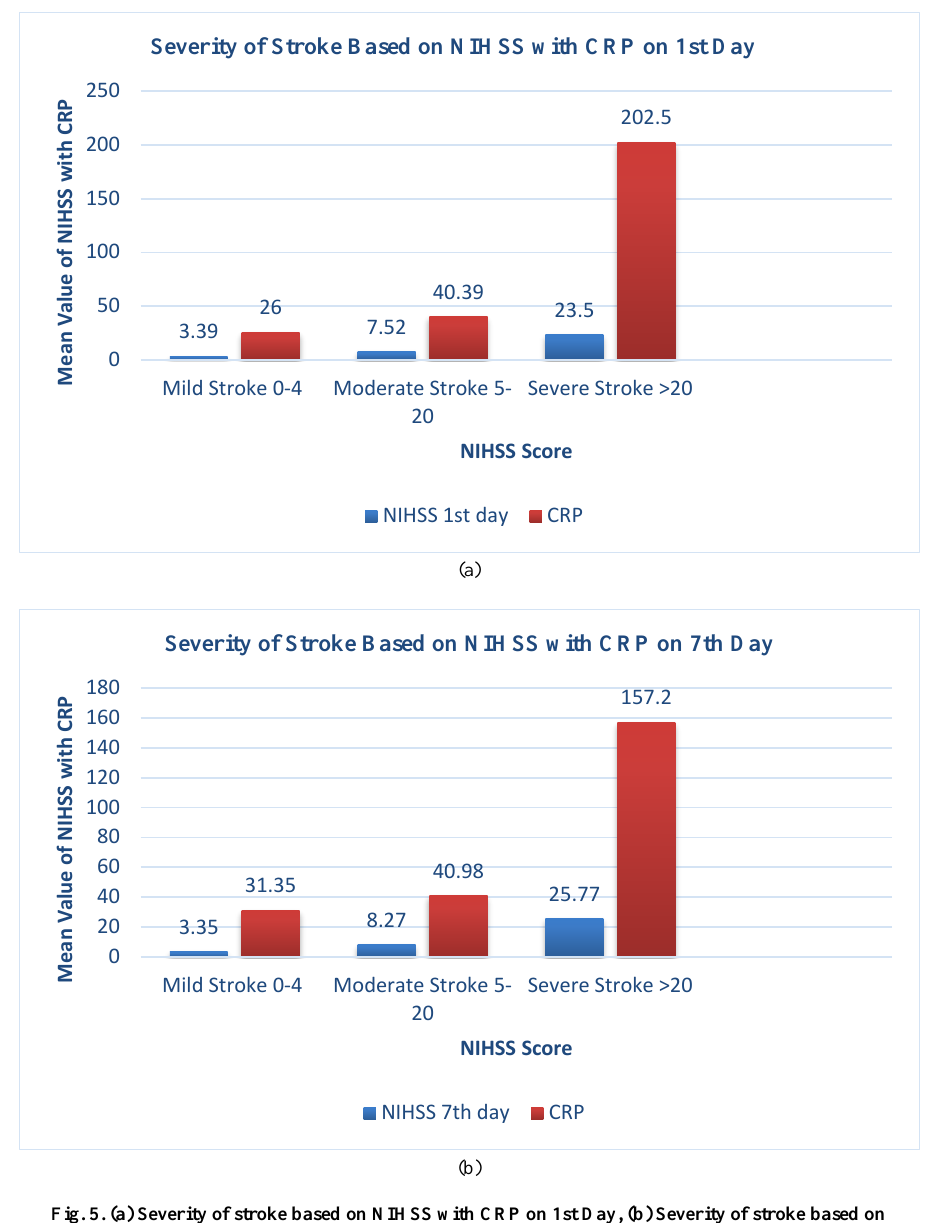
Fig. 5. (a) Severity of stroke based on NIHSS with CRP on 1st Day, (b) Severity of stroke based on NIHSS with CRP on the seventh